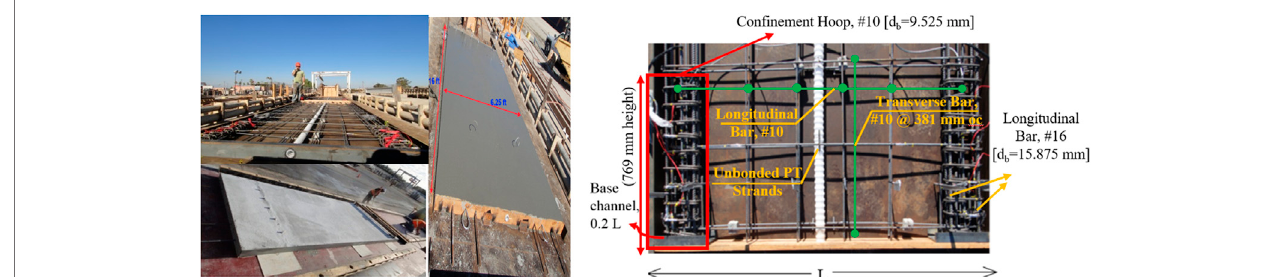
FIGURE 3 | Fabrication and design details of the wall panels.